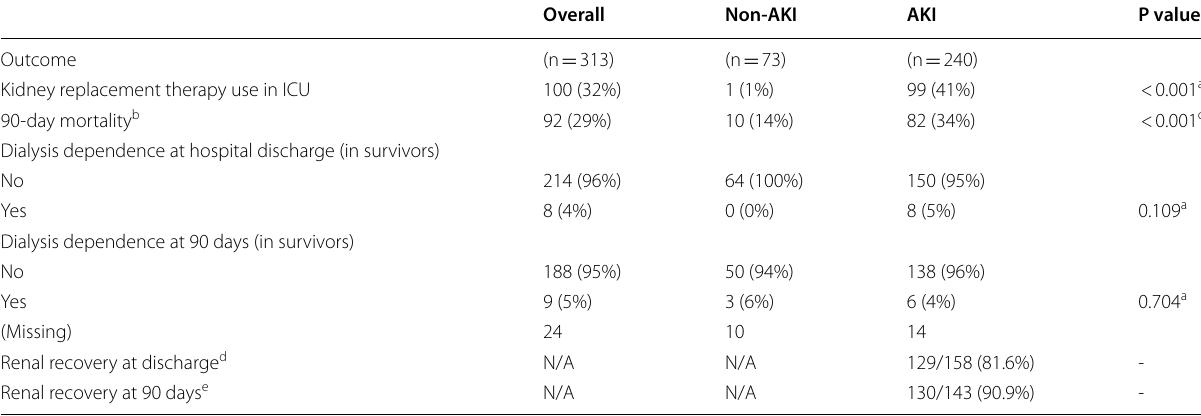
Table 4 Key outcomes by final acute kidney injury status